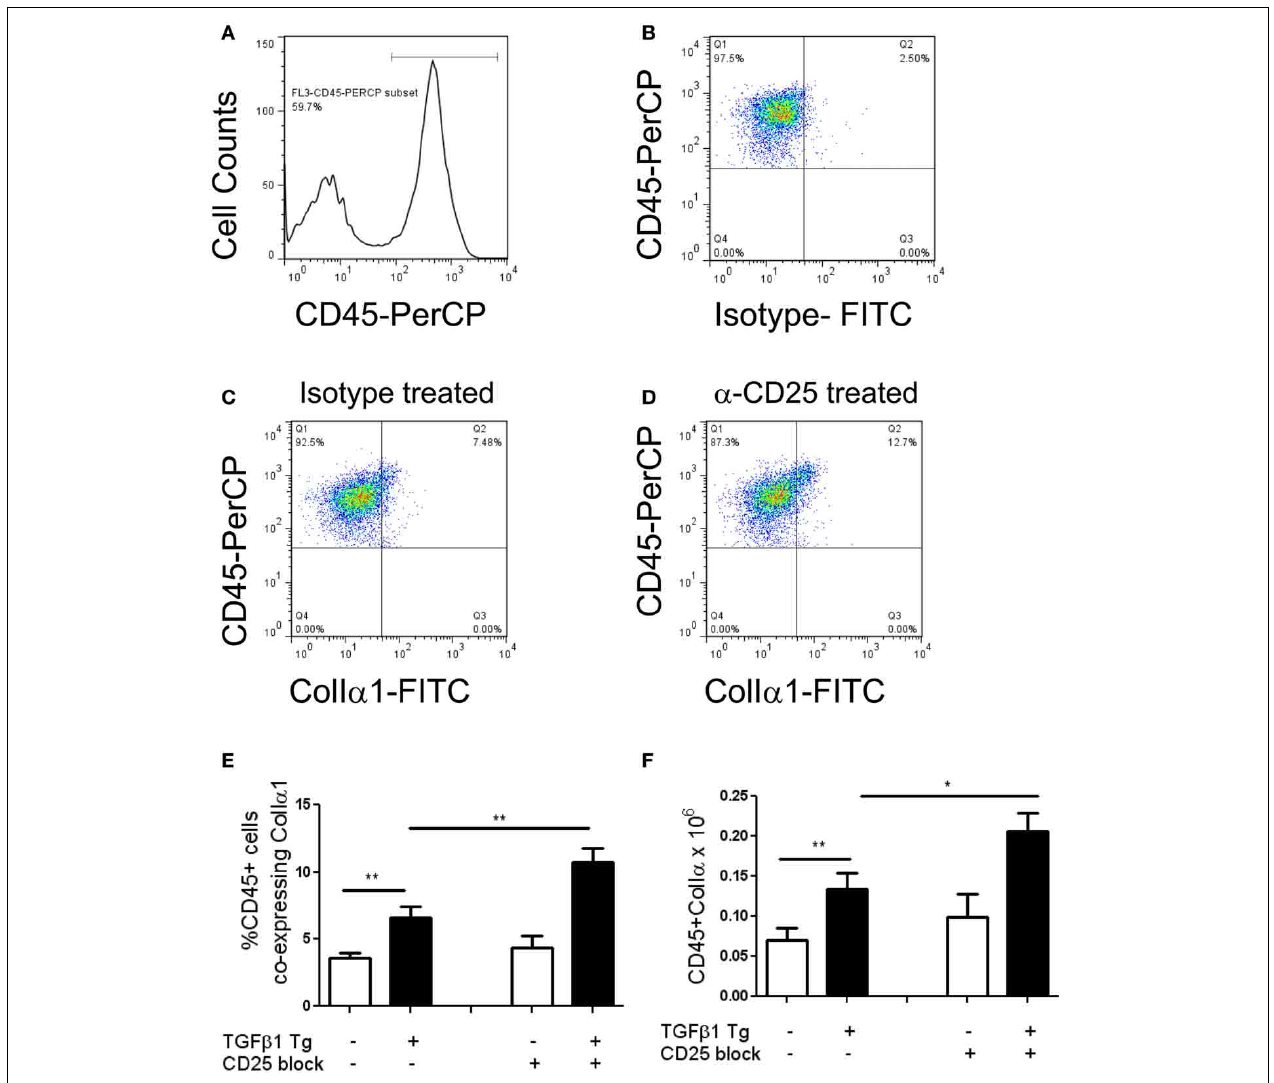
FIGURE 3 | Depletion of Tregs increases intrapulmonary fibrocytes in the TGF- β 1 exposed murine lung. Fibrocyte detection by flow cytometry of digested lungs from TGF- β 1 Tg + mice given doxycycline for 14 days and treated with isotype and anti-CD25 antibody. Panel (A) demonstrates the CD45 + population that was selected for analysis and Panel (B) presents FITC-detected intracellular isotype control (X axis) vs. CD45-PerCP (Y axis)